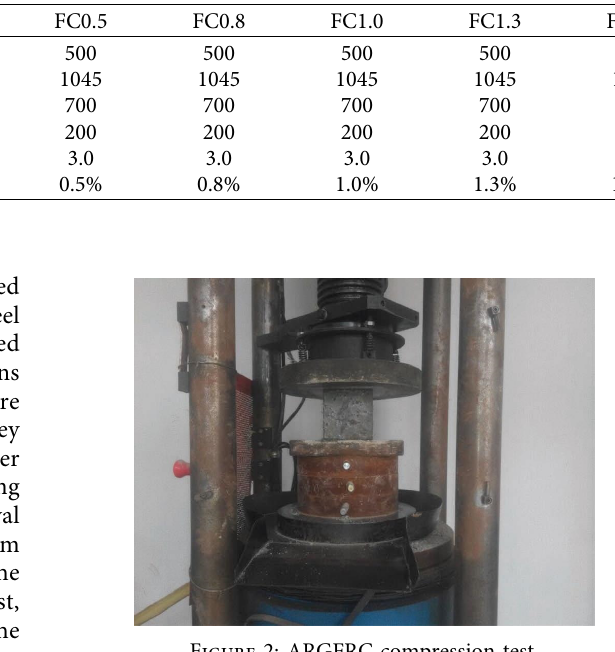
Table 2: ARGFRC mixture proportion design.